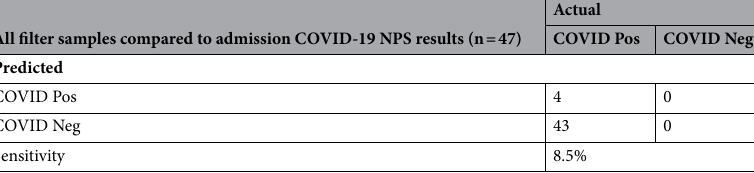
All filter samples compared to admission COVID-19 NPS results (n =